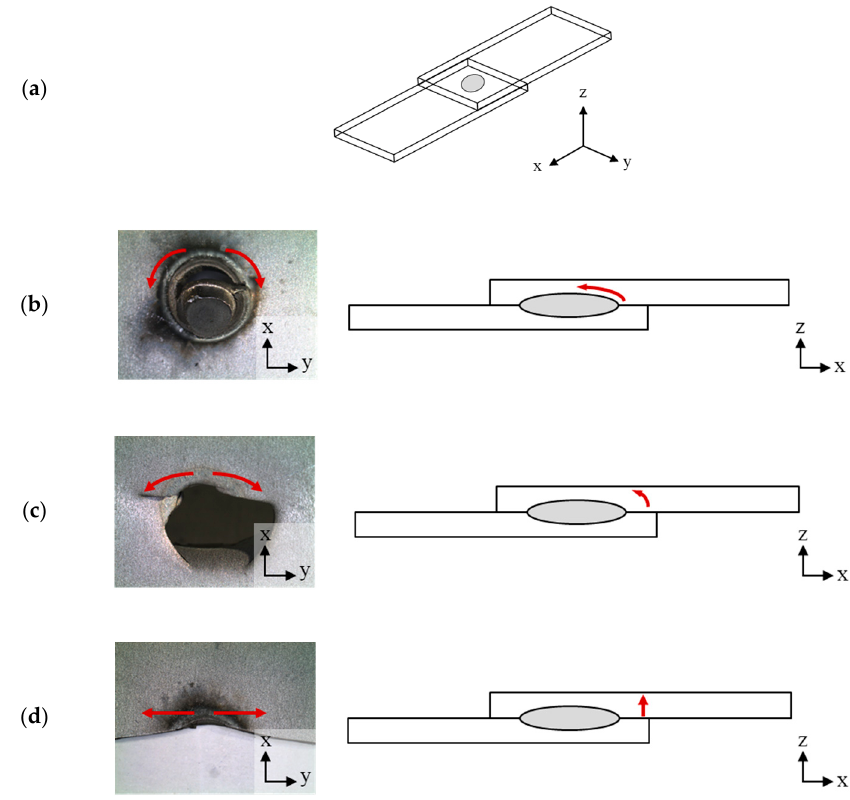
Figure 9. ( a ) Three dimensional schematic diagram indicating specimen. Crack propagation direction